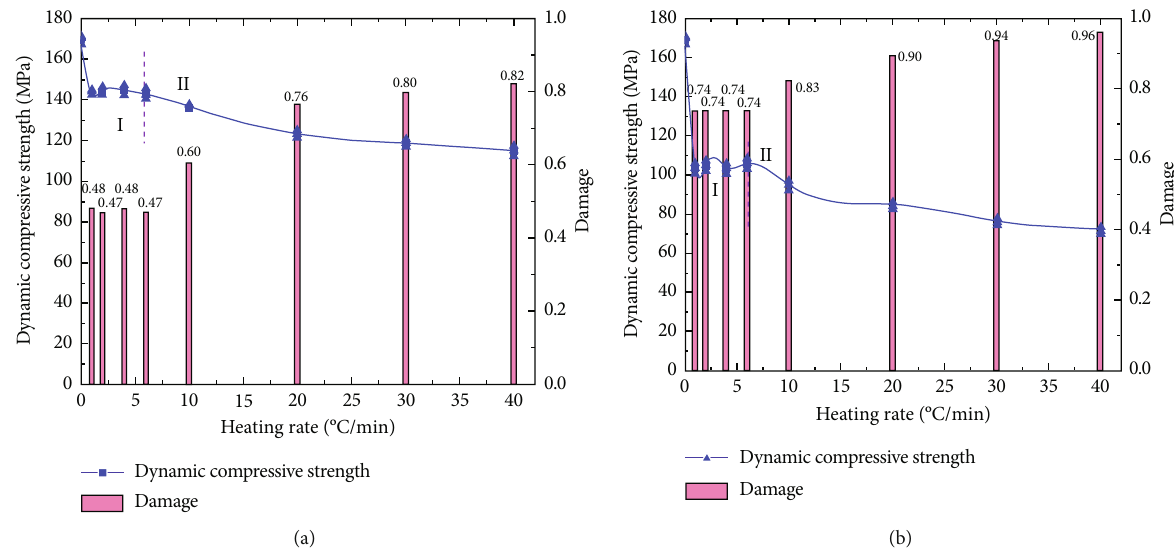
Figure 10: Damage e ff ect on the dynamic compressive strength of thermal shock treated granite specimens (a) T = 400 ° C and (b) T = 600 ° C